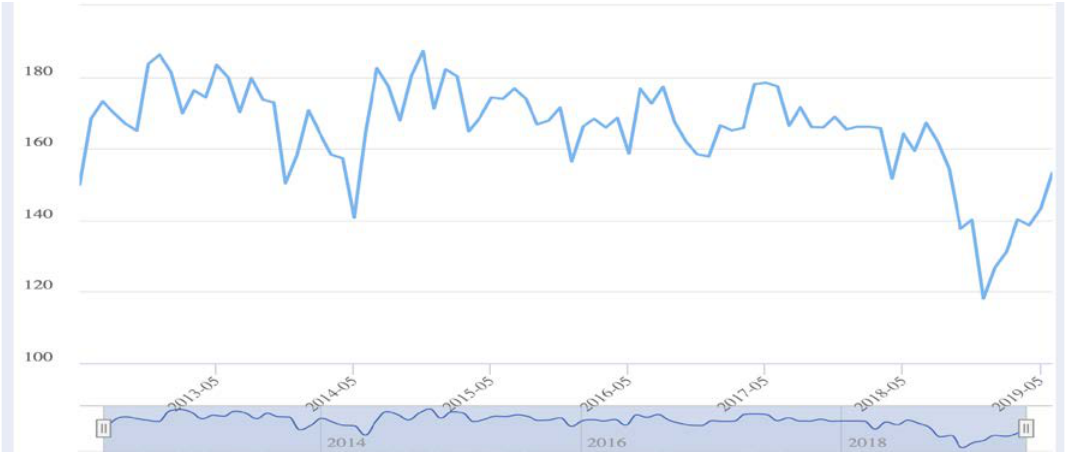
Figure 1. Financial Services Confidence Index: 2012:05-2019:05. Source : CBRT EVDS (2019a). Available at: https://evds2.tcmb.gov.tr/index.php?/evds/serieMarket Access date: